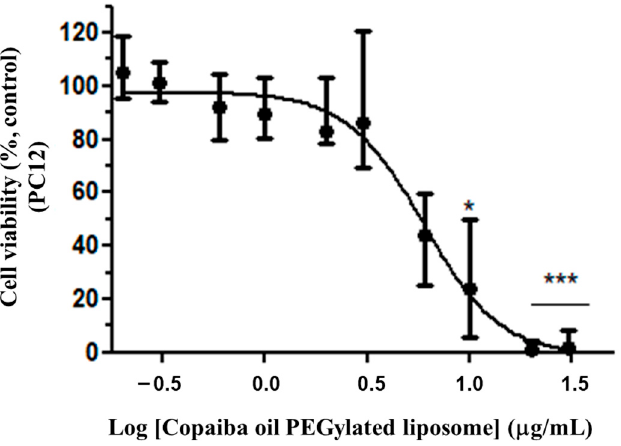
Figure 7. Cytotoxicity of CP-loaded PEGylated liposomes in PC12. Treatment at the dose of 0.2 to 30 μ g/mL of PC in PEGylated liposomes for 72 h. The graph represents the experiment closest to the median EC 50 value of 5.79 μ g/mL. Data are represented by a non-normal distribution in terms of the median and variation, analyzed by Kruskal–Wallis followed by Dunn’s comparison test. Statistical significance: (*) p < 0.01 and (***) p < 0.0001 compared to the control with 0.05% empty liposomes.